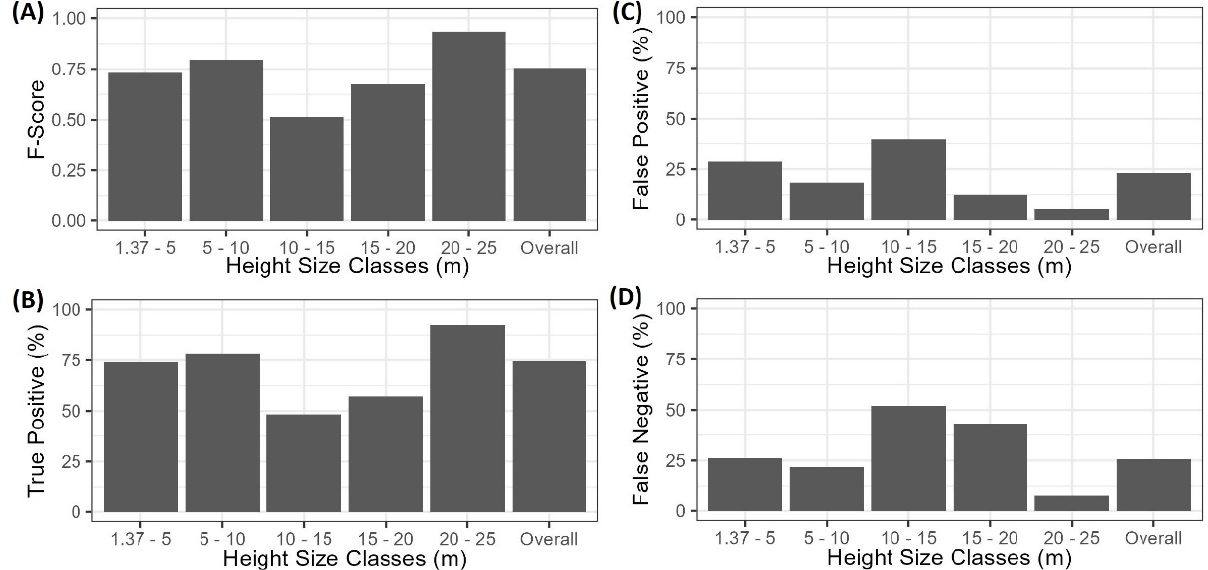
Figure 2. Summary of SfM tree extraction across height classes using a variable window filter. Panels represent ( A ) F-Score, ( B ) True Positive rate, ( C ) False Positive rate, and ( D ) False Negative rate.